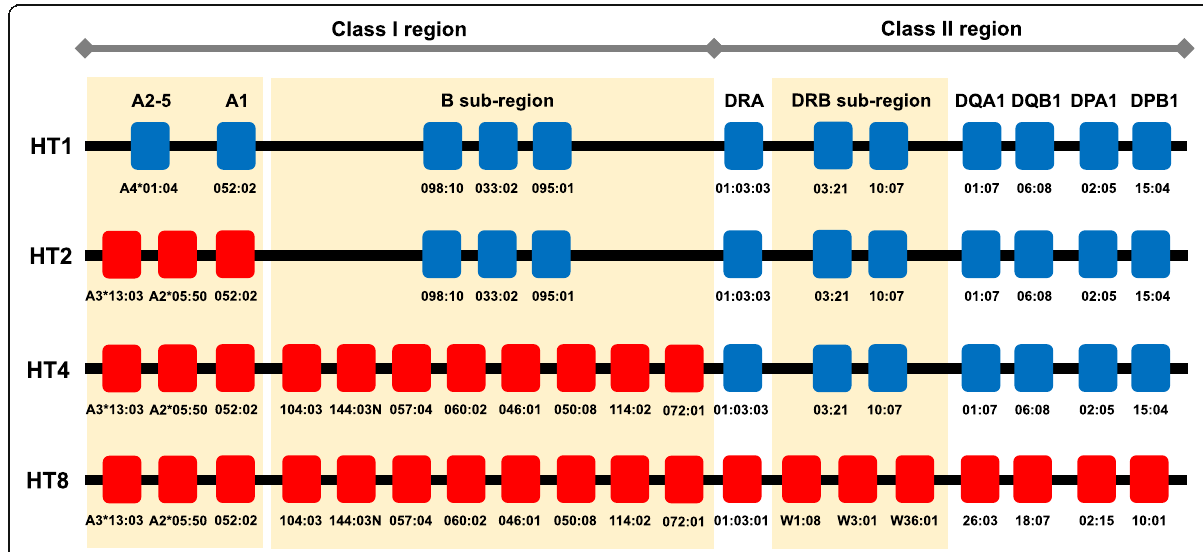
Fig. 3 Representative Mafa haplotypes in Philippine population. Blue and red indicate Mafa alleles originating from the HT1 haplotype and HT8 haplotype, respectively. Yellow background indicates Mafa gene segments that are organized by CNV